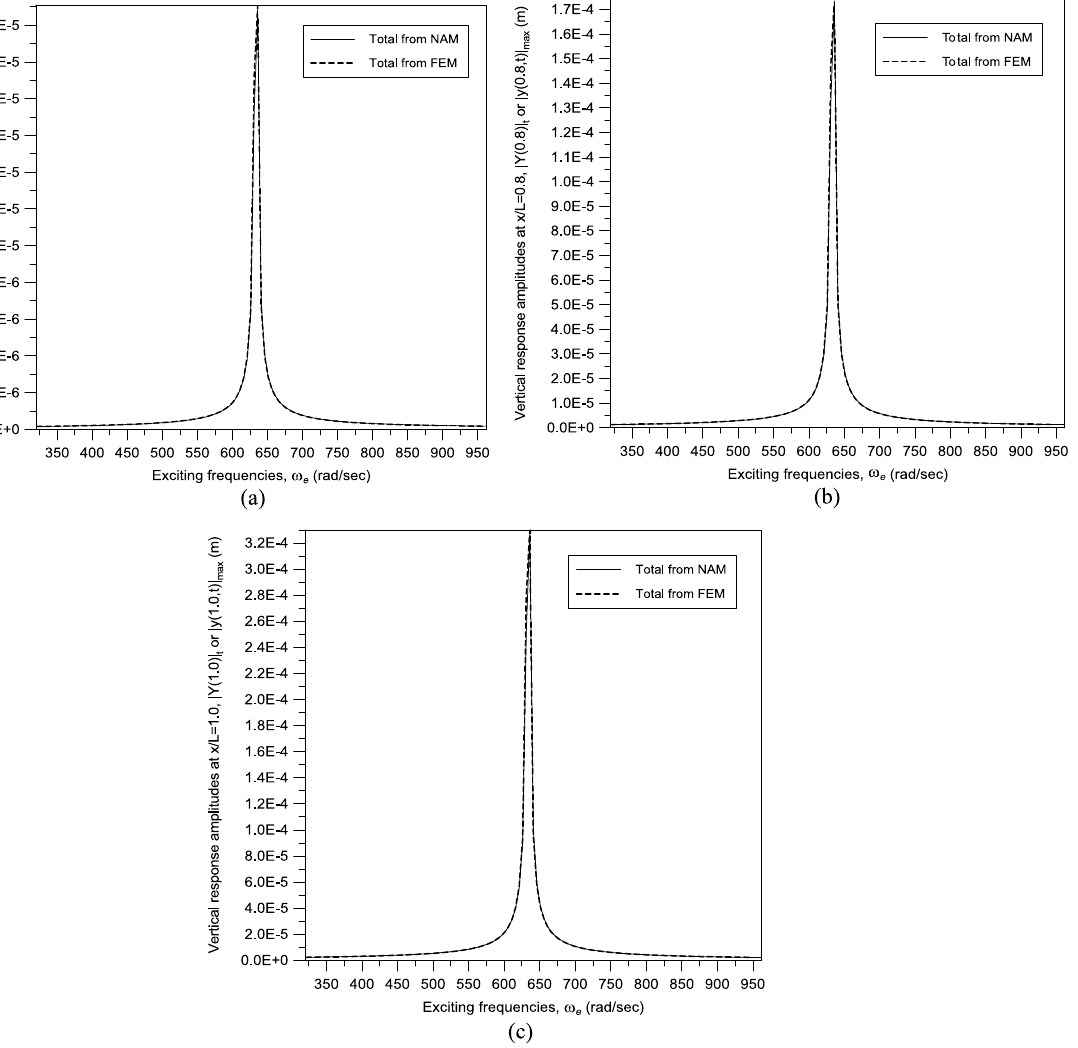
Fig. 5. The frequency-response curves for the three points p 1 , p 2 and p 3 on the beam (with “zero” initial conditions) shown in Fig. 4 located at: (a) ξ = x / L = 0.3, (b) ξ = x / L = 0.8 and (c) ξ = x / L =